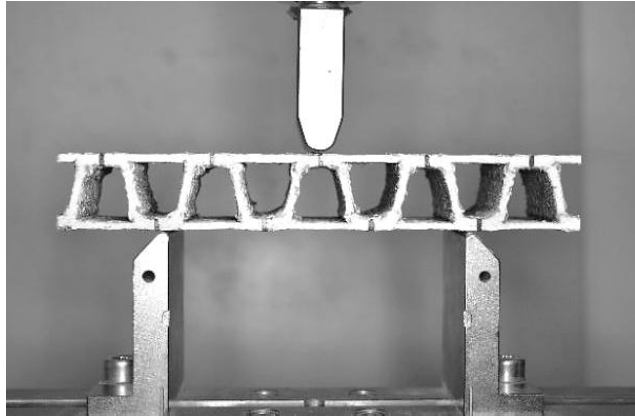
Figure 3. Sandwich specimen for three-point bending test.